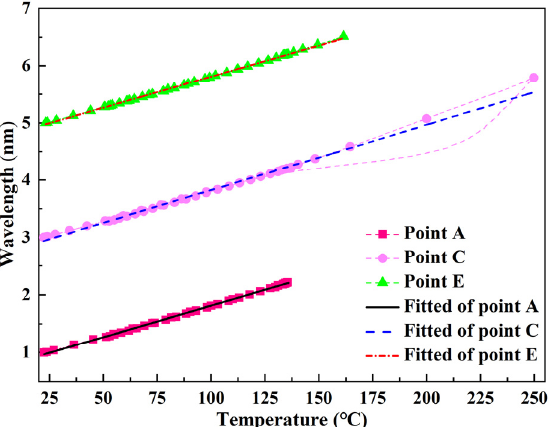
Figure 9. Relationship between temperature and wavelength.